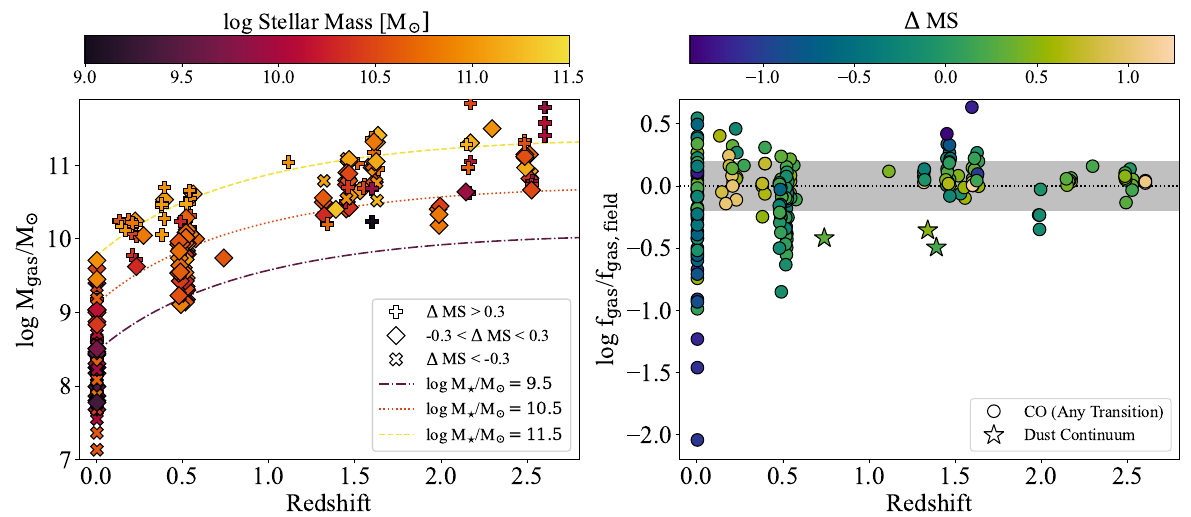
Figure 14. ( left ) Molecular gas mass as a function of redshift for Virgo galaxies and other various cluster samples. The lines represent the field-scaling relations at three different stellar masses, using the formulations in Tacconi et al. [603]. There is a clear increase in gas mass with increasing redshift, stellar mass, and offset from the star-forming Main Sequence, for both field and cluster galaxies. ( right ) The molecular gas fraction offset of cluster galaxies from the field-scaling relations at a given stellar mass, star formation rate, and redshift, for the same cluster galaxies in the left panel, while low-redshift clusters display a mix of depleted and elevated gas fractions, z > 1 cluster galaxies are preferentially elevated compared to the field with the exception of 2 galaxies at z ∼ 2 and stacked averages at z ∼ 1.4 using dust continuum as a proxy for molecular gas (stars). The gray shaded region represents the Tacconi et al. [603] field-scaling relations with an associated ± 0.2 dex